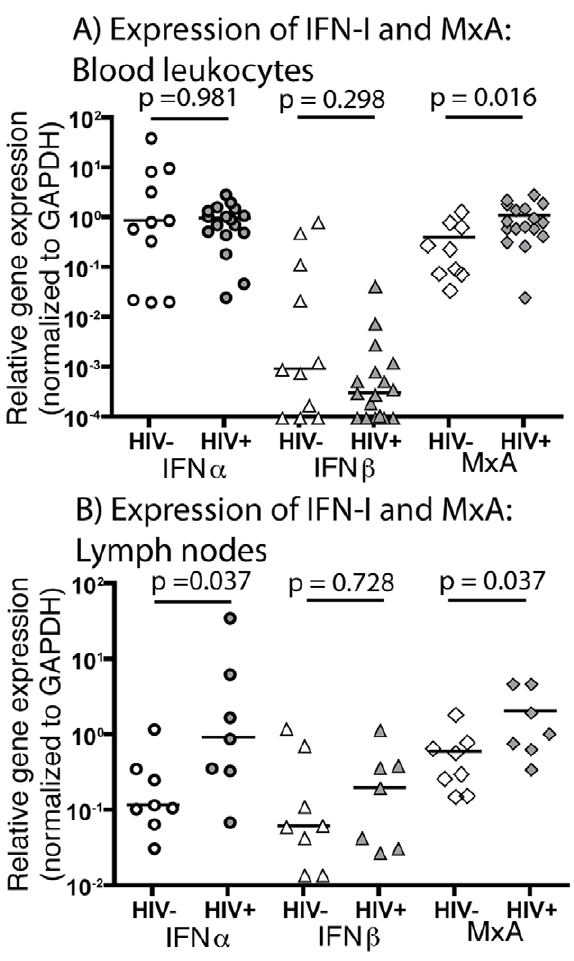
Figure 3. IFN a mRNA expression is elevated in lymph nodes, but not peripheral blood leukocytes, of HIV-1-infected sub- jects. There was no significant difference in expression of IFN a mRNA in whole blood leukocytes of HIV-1-infected subjects without ART (median relative expression of 0.10) and uninfected subjects (median relative expression of 0.88) (p=0.981) (A). Similarly, there was no significant difference in IFN b mRNA expression in whole blood leukocytes (median relative expression of 0.003 for HIV-1-infected subjects, median relative expression of 0.001 for uninfected subjects; p=0.298) (A). An IFN-I signature was evident in peripheral blood leukocytes, as expression of the ISG MxA was significantly increased in HIV-1-infected subjects without ART compared to uninfected subjects (median relative expression of 0.85 for HIV-1-infected subjects, median relative expression of 0.26 for uninfected subjects; p=0.016) (A). In contrast, expression of IFN a mRNA in lymph node tissue was significantly elevated in HIV-1-infected subjects without ART (median relative expression of 0.93) relative to uninfected subjects (median relative expression of 0.12) (p=0.037) (B). There was no statistically significant difference in IFN b mRNA expression between the two donor groups (median relative expression of 0.20 for HIV-1-infected subjects, median relative expression of 0.06 for uninfected subjects; p=0.728) (B). Expression of the ISG MxA was significantly increased in lymph node tissue from HIV-1-infected subjects compared to uninfected subjects (median relative expression of 1.05 for HIV-1-infected subjects vs. 0.45 for uninfected subjects; p=0.037) (B).